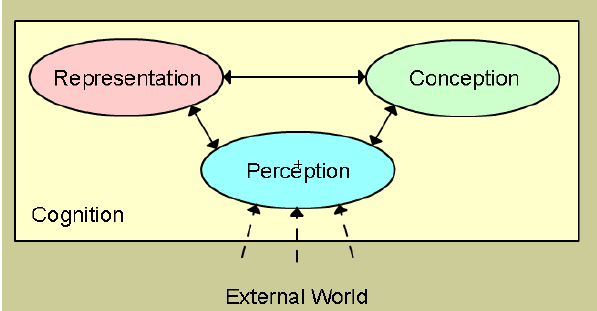
Figure 1. Idealized model of cognition - cognitive processing (Adopted from Williams, 1996).